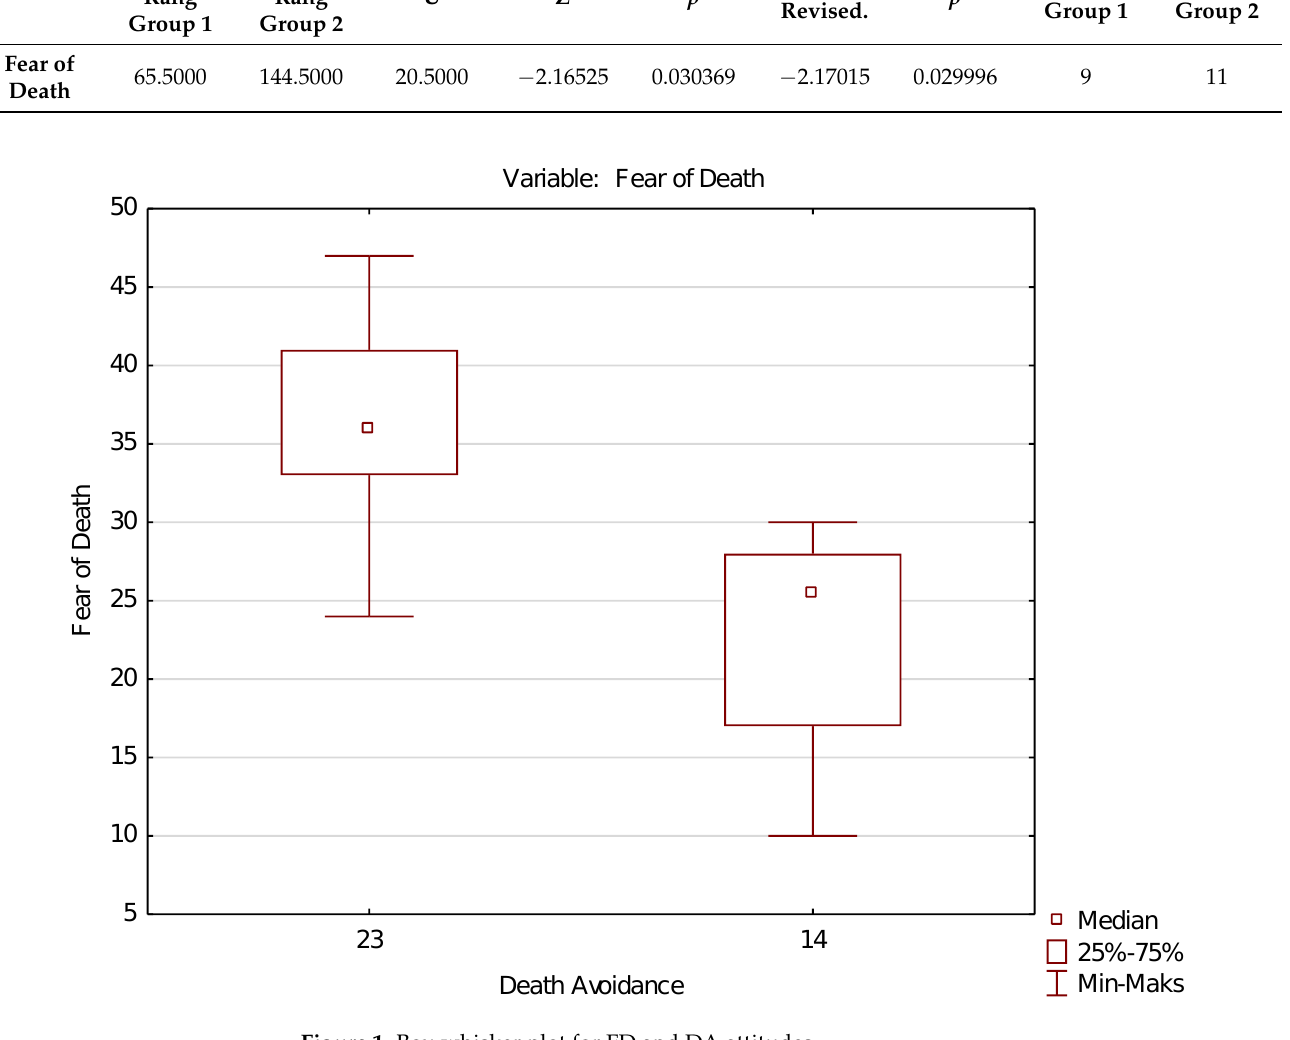
Figure 1. Box-whisker plot for FD and DA attitudes. Table 5. The results of the Mann – Whitney U test for variables: AA and AE.